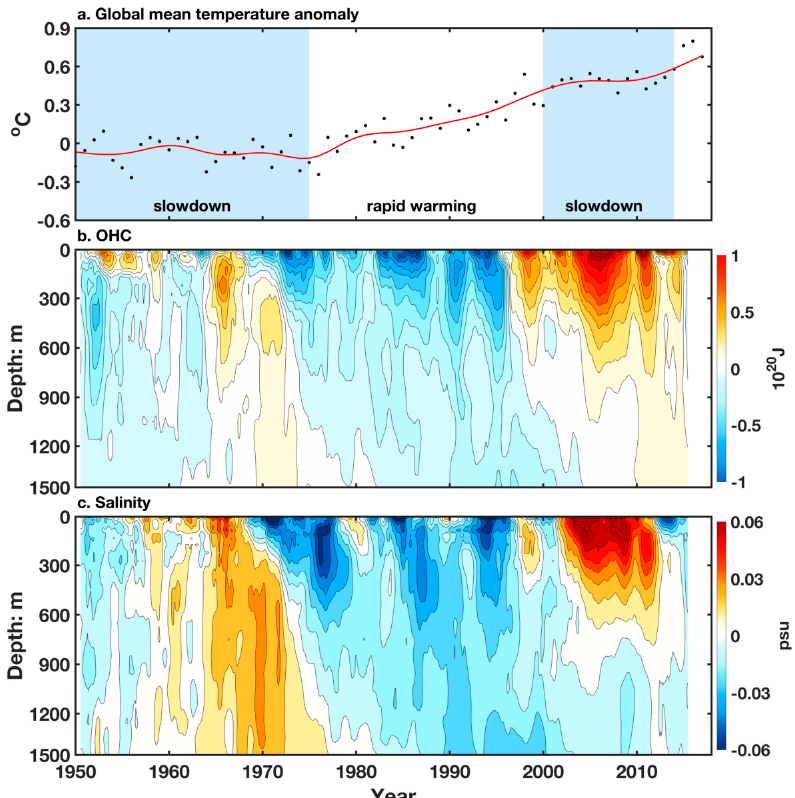
Figure 2. Coincidence of the three AMOC phases with global warming slowdown and acceleration: ( a ) Global mean surface temperature; ( b ) OHC north of 45 ◦ N in the Atlantic; ( c ): Salinity north of 45 ◦ N in the Atlantic. Adapted and updated to the end of 2017 from Chen and Tung